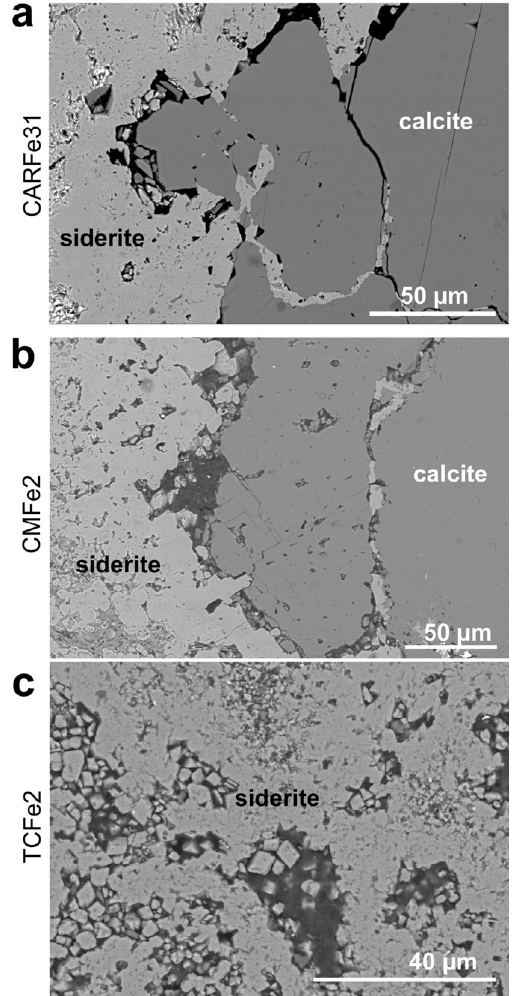
Figure 1. Backscattered electron (BSE) contrast images of the reaction interface between the original calcite and the replacing phase, siderite. ( a ) CAR marble reacted for 32 days, and ( b ) CM limestone reacted for 2 days. ( c ) shows the middle of the TC sample reacted for 2 days. Only siderite is visible which indicates complete